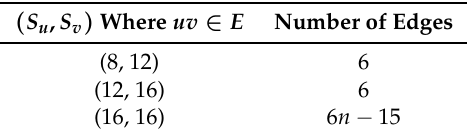
Table 9. Edge partition of G n ( n each edge.